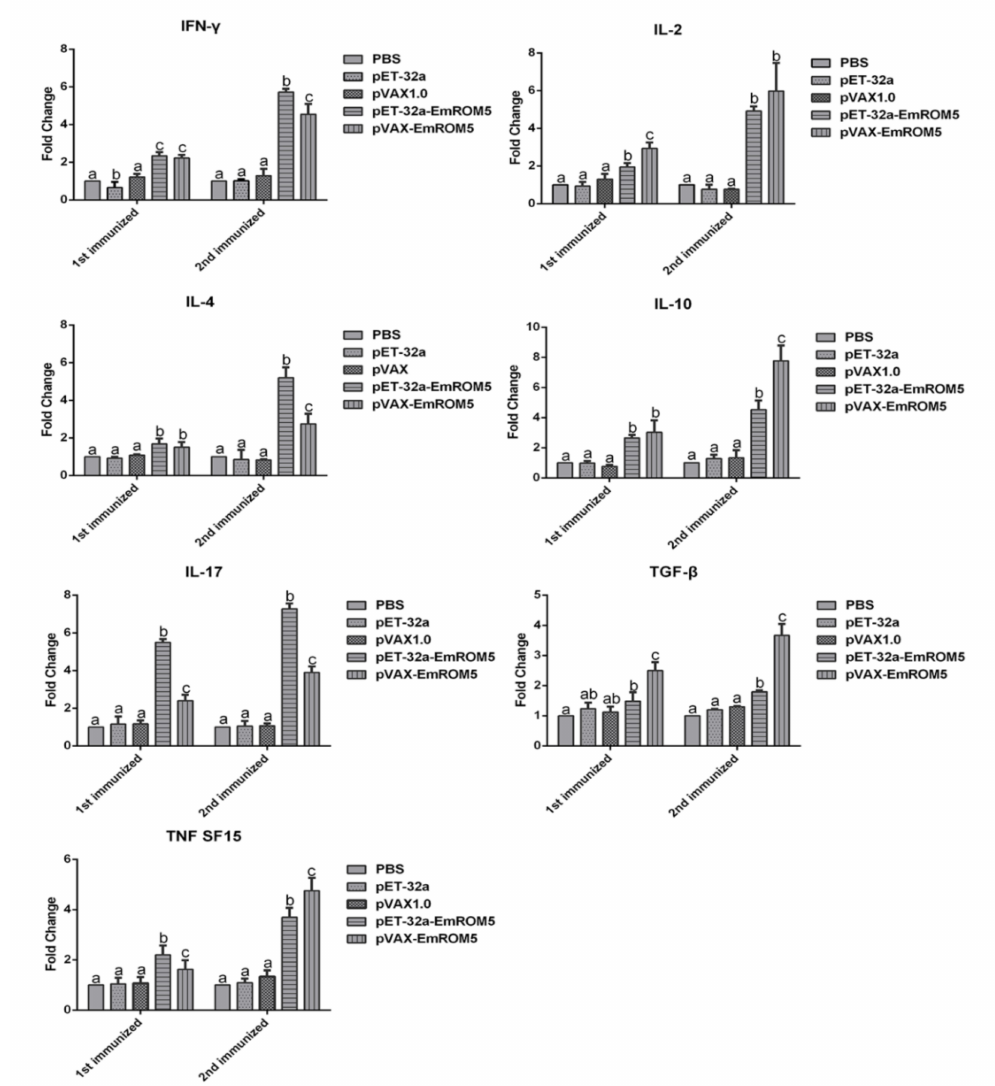
Figure 4. Changes in mRNA transcription of cytokines in splenic lymphocytes following the im- munization of rEmROM5 and pVAX-EmROM5 ( n = 5, value = mean ± SD). Significant difference ( p < 0.05) between numbers with different letters, and no significant difference ( p > 0.05) between numbers with the same